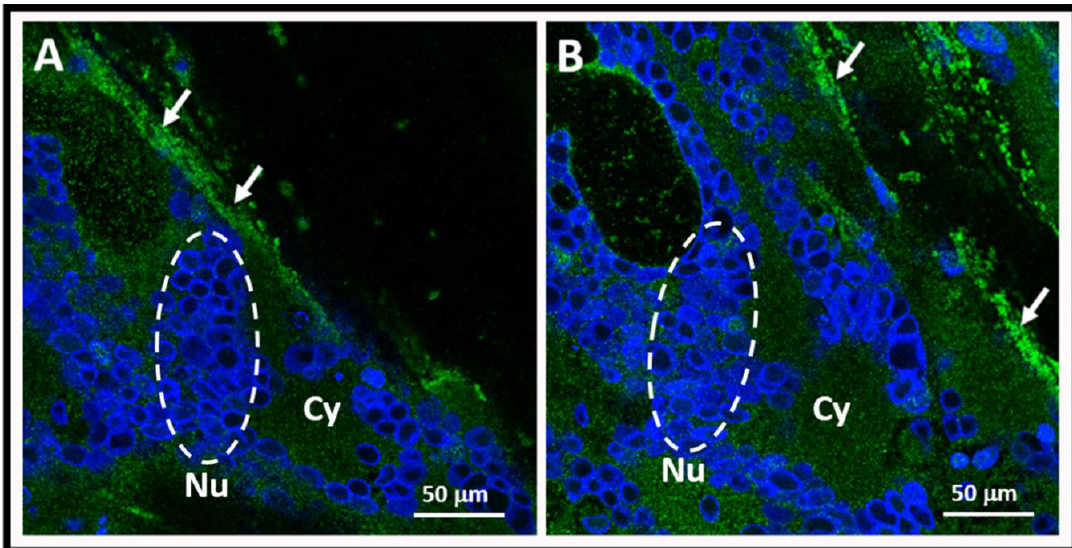
Figure 3. Varicella antibody in the cerebrospinal fluid. Varicella antibody was detected by a fluorescent antibody to membrane antigen test. The test was carried out by confocal microscopy imaging of varicella-zoster virus (VZV) infected monolayers. Two confocal images are shown ( A and B ). Clusters of nuclei (Nu; blue circles) within the cytoplasm (Cy) of an infected cell are encircled by a dashed white line. Arrows point to positive fluorescent antibody attaching to VZV antigens in the plasma membrane. The majority of the positivity resides in the plasma membranes of the infected cells because that is where the majority of viral glycoproteins are located. One viral target is VZV glycoprotein gE. Table 2. Prominent features among twice-immunized adolescents with varicella vaccine meningitis. Category Case 1 [10] Case 2 [11] Case 3 [11] Case 4 [1] Geography Boston Seattle Seattle Des